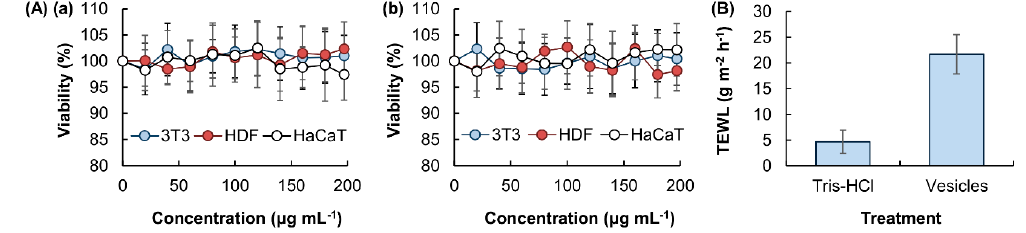
Figure 2. ( A ) The viability of 3T3, HDF and HaCaT cells after 5 h treatment with blank vesicles, ( a ) without or ( b ) with 24 h post-treatment incubation prior to the MTS assay. Data are presented as the means ± standard deviation (SD) of triplicate experiments. ( B ) TEWL values of a vesicle-containing solution and 1M Tris-HCl buffer. Data are presented as the means ± SD of triplicate experiments.